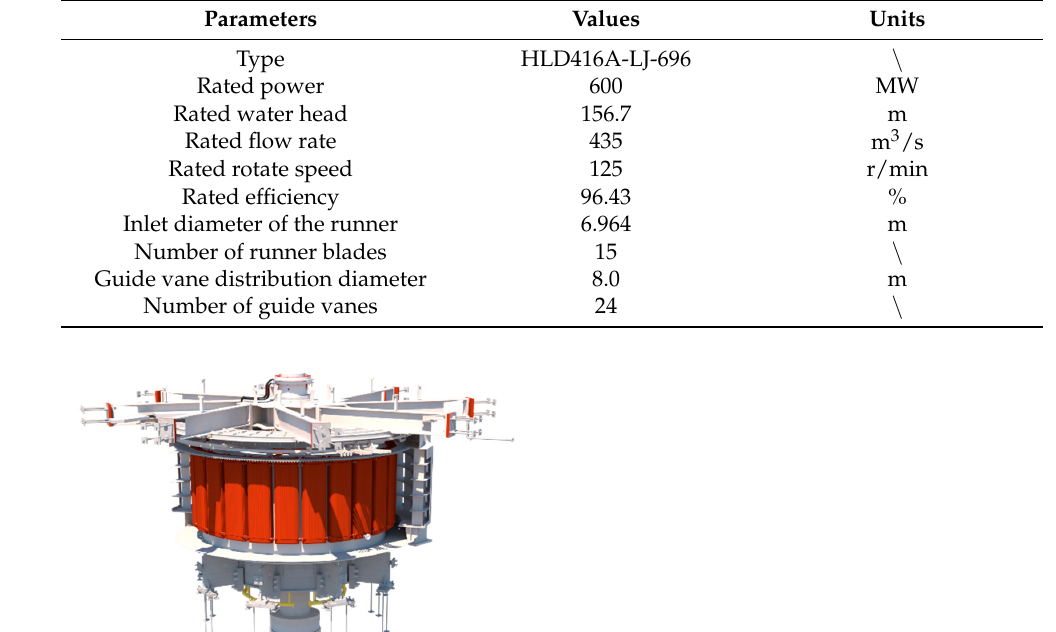
Table 1. Basic performance parameters of the FTU.